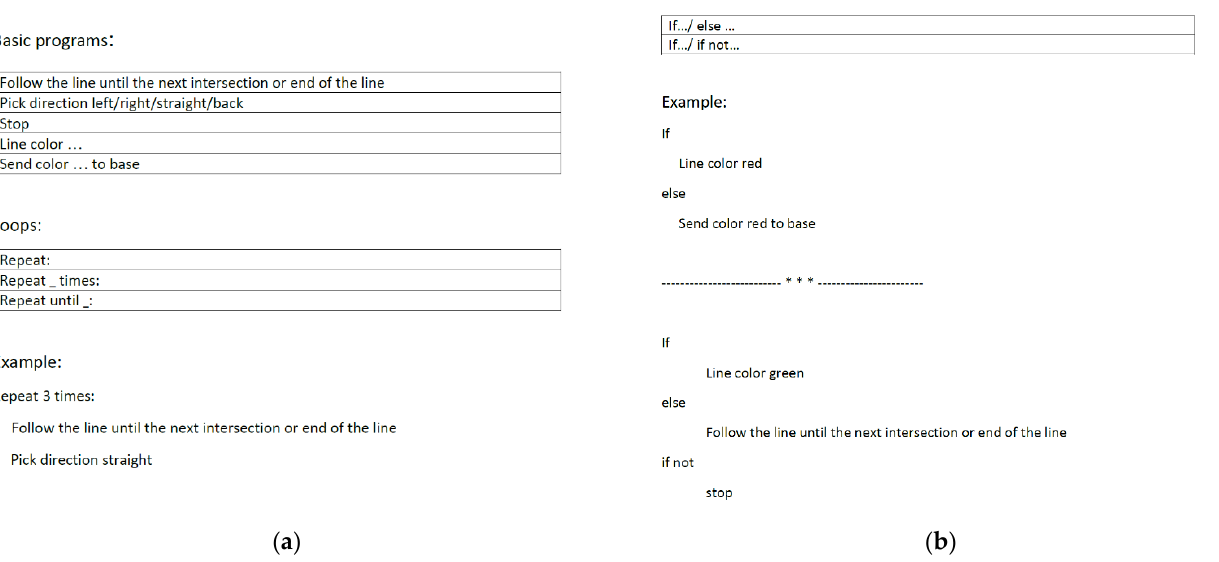
Figure 2. Instructions for students to program the spatial robot: ( a ) basic programs and loops, with an example; and ( b ) conditionals with examples.